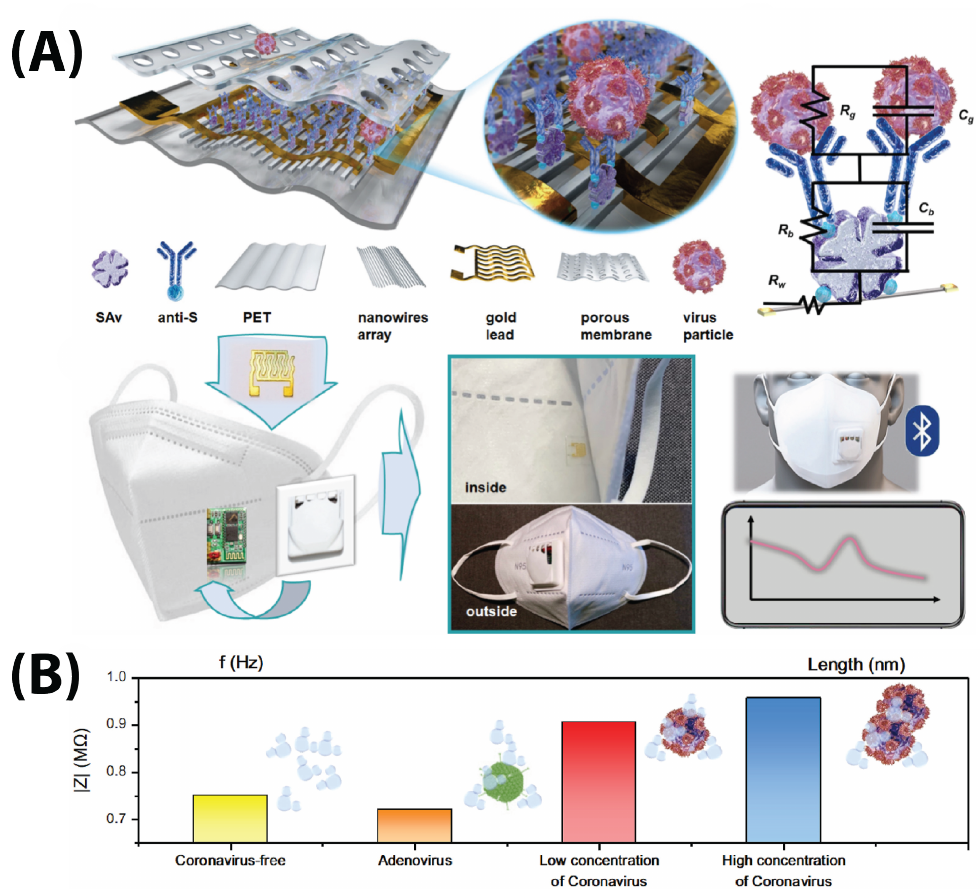
Figure 5. ( A ) Xue et al. developed a mask-integrated sensor using interdigitated Au nanowires [69]. ( B ) The impedance response increases with the presence of viral particles. This is reprinted with permission from Elsevier